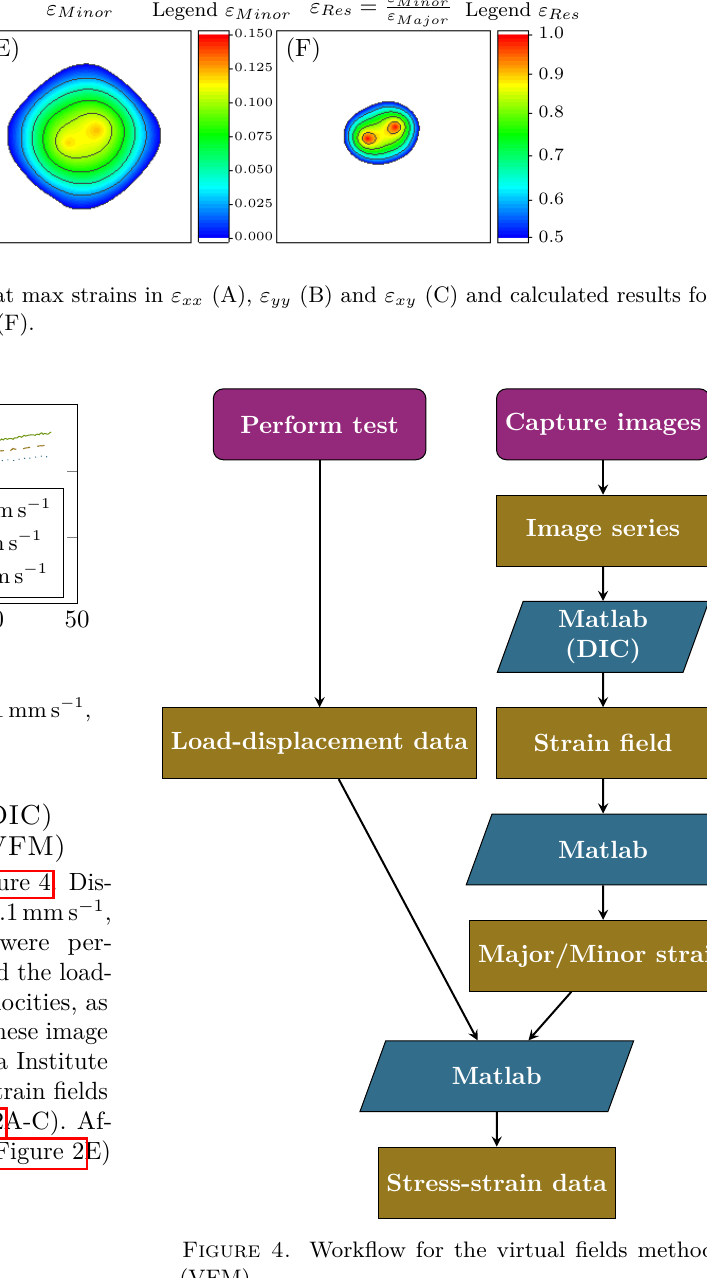
Figure 4. Workflow for the virtual fields method